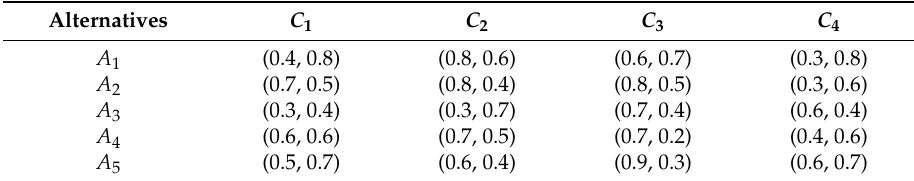
Table 1. The Pythagorean fuzzy decision matrix provided by the E 1 .